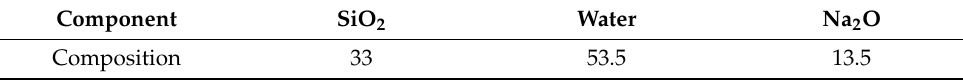
Table 3. Percentage mass composition of chemical compounds of sodium silicate activator.